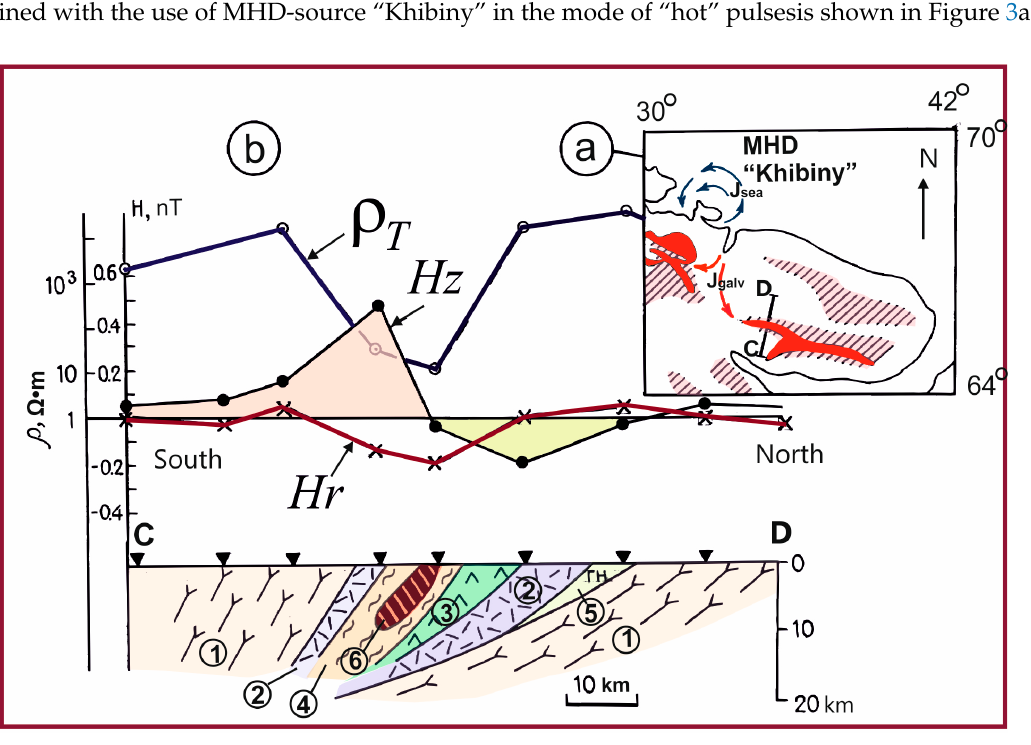
Figure 3. Example of current-conducting channels study on the Kola peninsula with the use of MHD-source “Khibiny” in the mode of “hot” pulses. ( a ) The view of conductive structures and MHD currents in the sea (blue arrows) and the Earth crust (red arrows); ( b ) current-conducting channel’s study over the Imandra-Varzuga structure by profile CD. Legend (numerals in circles): 1 — granite-gneiss; 2 — volcanites; 3 — effusives; 4 — schists and volcanites of the Tominga Series; 5 — gabbro-norites; 6 — location of the conductive channel